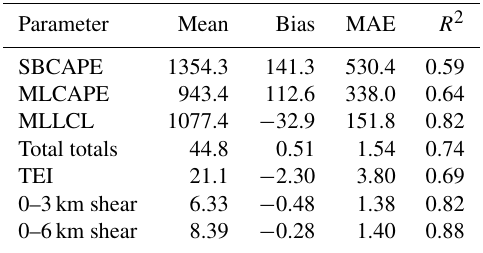
Table 3. RAP error statistics for surface-based CAPE (SBCAPE) and several of the variables listed in Table 2. The statistics are pre- sented similarly to Thompson et al. (2003) by providing the mean RAP-derived value, the mean arithmetic error (bias), and the mean absolute error